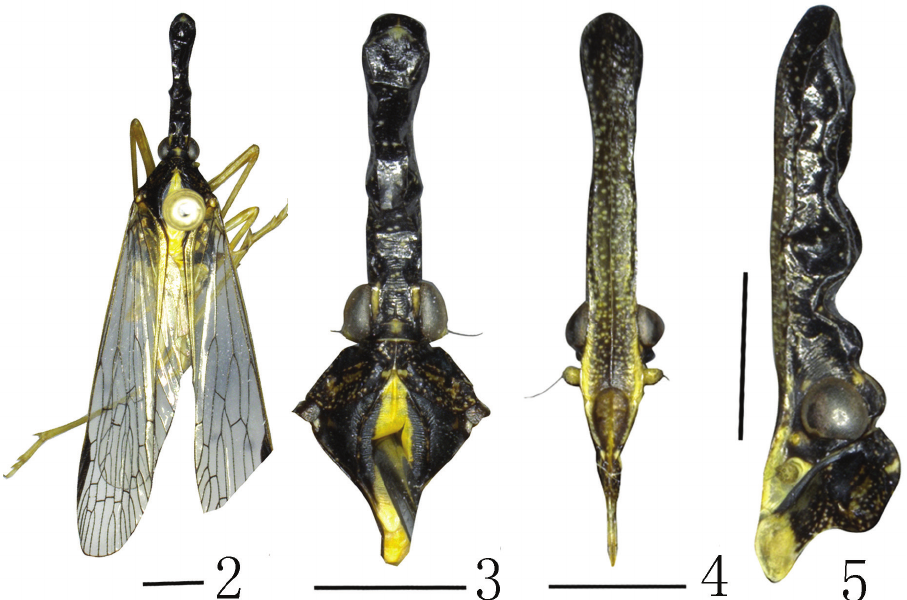
Figures 2–5. Saigona baiseensis Zheng & Chen sp. nov. 2 male, holotype, dorsal view 3 male, head and thorax, dorsal view 4 male, head, frons and clypeus, lateral view 5 male, head and pronotum, lateral view. Scale bars: 2 mm ( 2–5 stripe. Ventral thorax and fore femur dark, other areas yellow. Legs ochraceous except coxae which are dark. Forewing venation brown and pterostigma dark. Abdomen dark with scat- tered white speckles and median longitudinal yellowish stripe. Male genitalia black. Head and thorax . Head (Figs 2–5) longer than pronotum and mesonotum com- bined (1.45:1). Vertex (Fig. 3) with median carina very faint, only conspicuous at apex and base; lateral carinate margins sinuate. Frons (Fig. 3) with lateral carinae reaching to front of eyes. Pronotum (Figs 2, 3, 5) with median carina distinct, lateral carinae very faint. Mesonotum (Figs 1, 2) tricarinate on disc, lateral carinae curved towards median carinate at the front. Fore wings (Figs 2, 6) hyaline with ScP+R, MP and Cu branched apically, longer than widest part, with length to maximum width ratio of 3.0; stigma distinct, with 3 or 4 cells, veins with numerous fuscous setae. costal margin dis- tinctly expanded into a narrow, sclerotized costal area, without transverse veins; ScP+R branched apically; MP bifurcating into MP and MP at basal 3/5 and beyond CuA; 1+2 3+4 CuA forked near middle of forewing; 13 apical marginal cells between RP and CuA; Pcu and A fusing at apical 2/5 of clavus. Hindwings (Fig. 7) well developed, legs mod- 1 erately elongate, fore femora flattened and dilated; hind tibiae with 5 or 6 lateral black- tipped spines and 8 apical black-tipped teeth, spinal formula 8/(10–12)/(10–12). Male genitalia . Pygofer (Figs 8–10) large and broad in lateral view, posterior mar- gin with a rounded lobe at level of venter of anal tube. Gonostyli (Figs 8, 9) relatively large and broad, apex sharply rounded, protruded posteriorly in lateral view on the